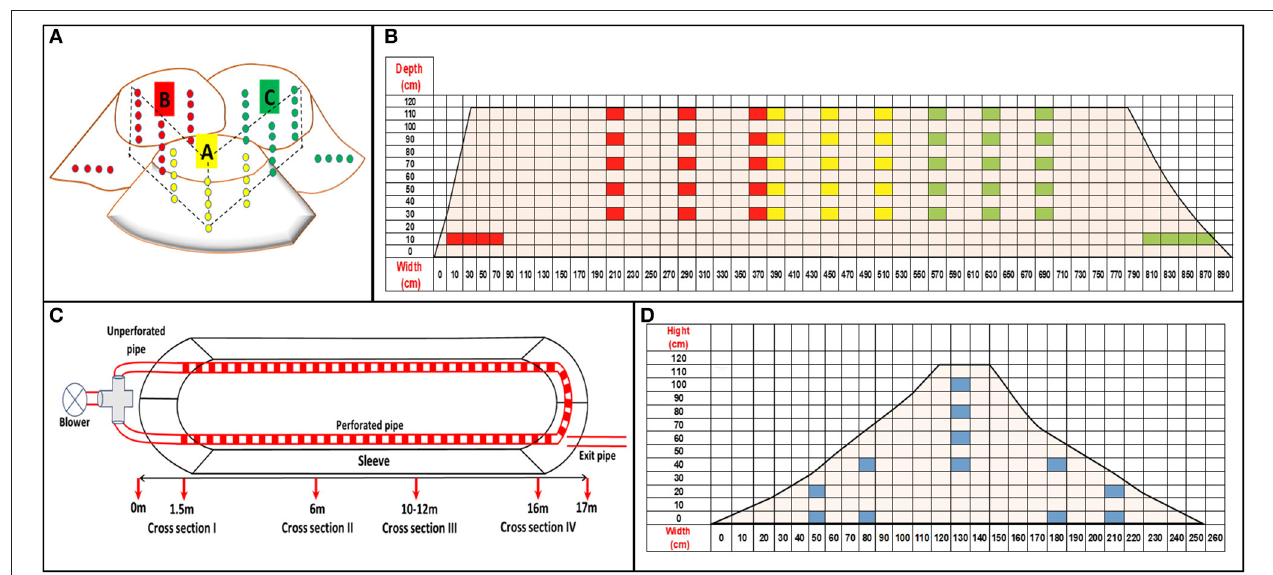
FIGURE 1 | Setup geometry and the location of sampling points in the stockpile (A,B) and the sleeve (C,D) . The cross-section of the stockpile connects the centers of three subpiles. The sleeve was divided into four sections, each was represented by a cross-section at 1.5-, 6-, 10- to 12-, and 16-m distance from the blower (denoted as CS-I –